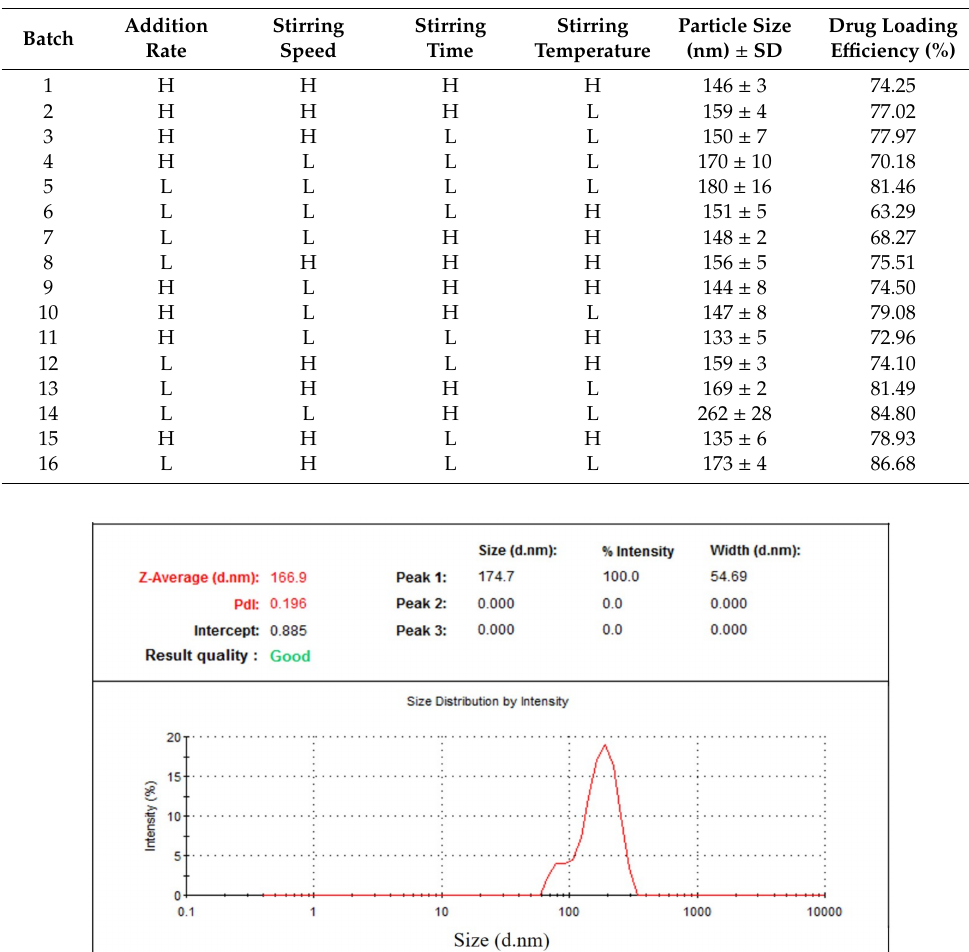
Table 1. Design of Experiment (DoE) of process parameters (PP) for nanophytosome batches. H and L denote high and low, respectively.